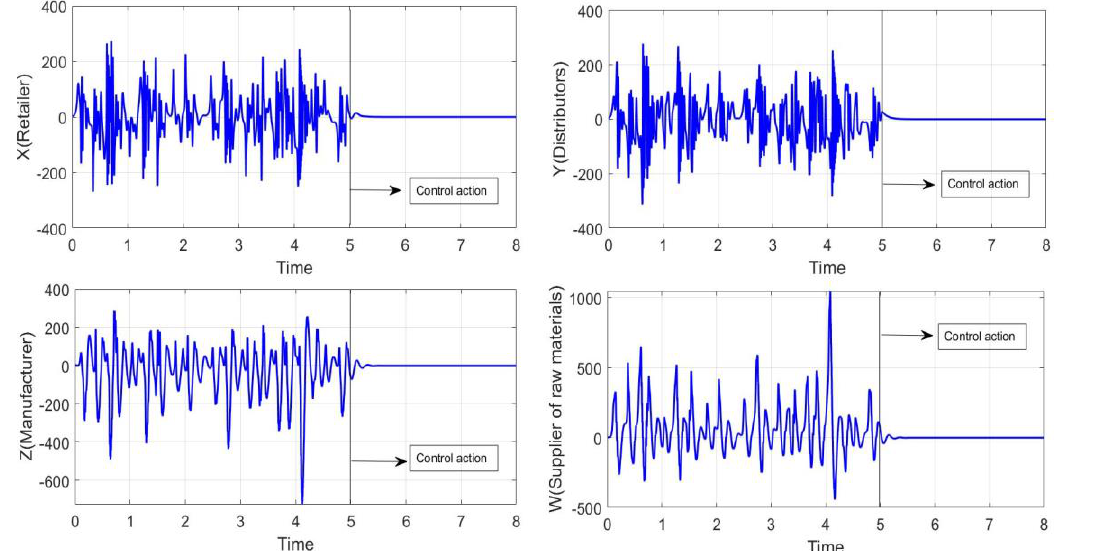
Fig. 11. Elimination of hyper chaotic behavior in the supply chain with control policy in the distributor.